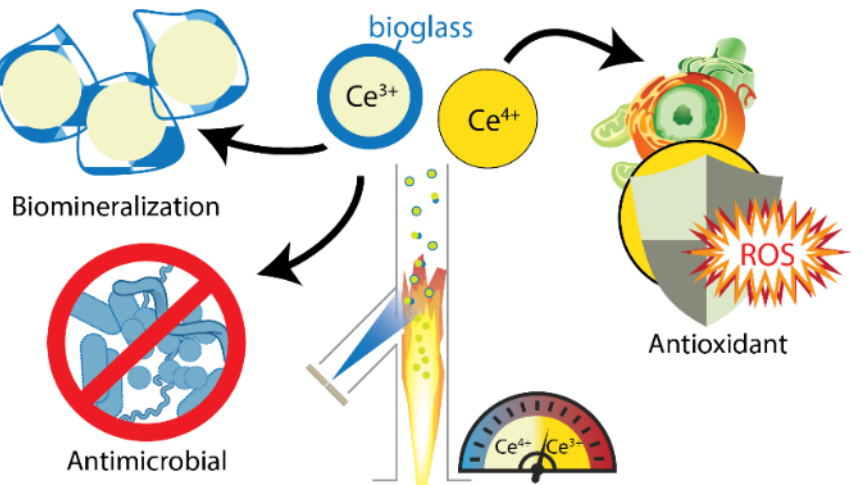
Figure 1. Engineered nanoceria structures are used as stand-alone materials, as support matrices for nanohybrids, or as coatings. The activity of nanoceria, whether acting as an antioxidant, protecting mammalian cells from oxidative death, or suppressing microbial growth, is regulated by specific environmental conditions. Reprinted (adapted) with permission from [54]. Copyright 2023 American Chemical Society.